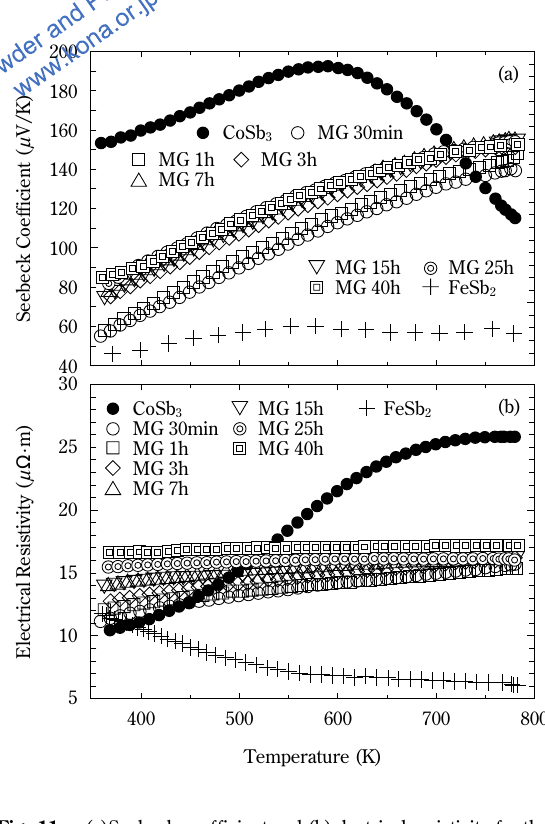
Fig. 13 (a)Figure of merit for the CoSb 3 -FeSb 2 composite whose molar ratio of CoSb 3 to FeSb 2 is 0.8:0.2 as a function of the temperature and MG time. (b)Figure of merit for the CoSb 3 -FeSb 2 composite whose MG time is fixed at 25h and molar ratio of CoSb 3 to FeSb 2 is 1-x:x as a function of the temperature.